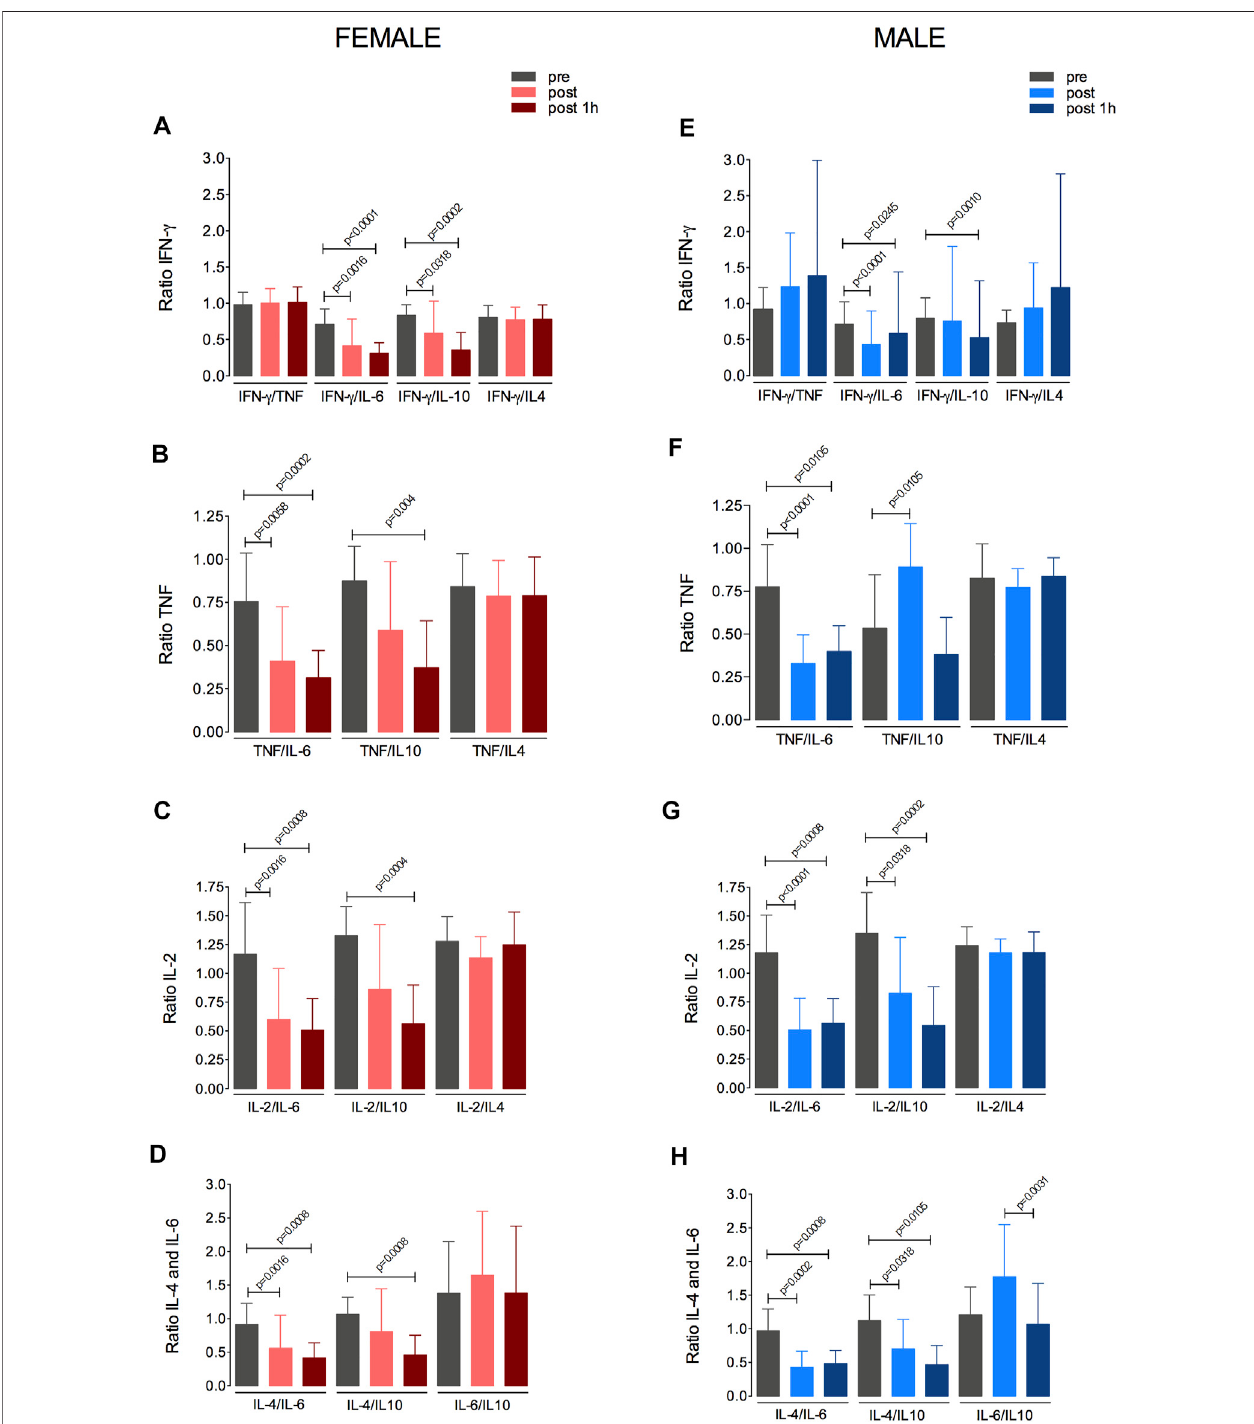
FIGURE5| ChangesinIFN γ ,TNF α ,IL-6,IL-2,IL-4,andIL-10levelsinresponsetothefatiguingexerciseprotocol.ChangesinthelevelsofIFN γ (A,B) ,TNF α (C,D) , IL-2 (E,F) , IL-4 (G,H) in the female and male groups are shown. IFN, interferon; TNF, tumor necrosis factor; IL, interleukin.